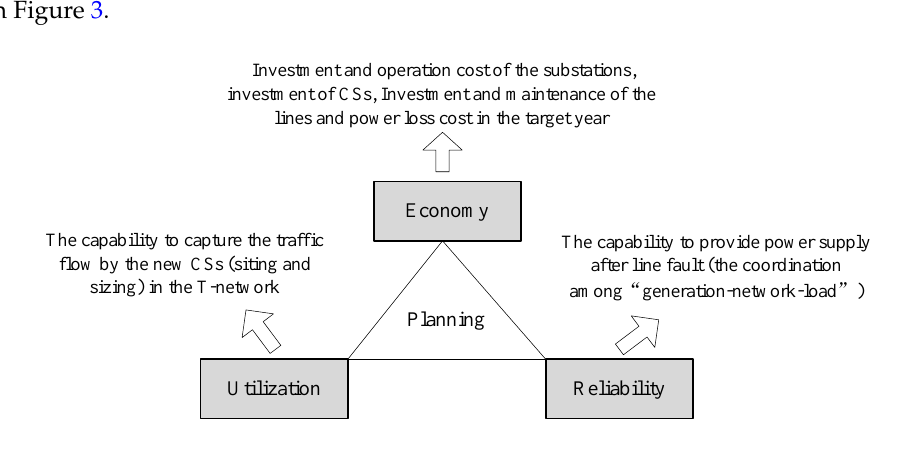
Figure 3. Three objectives for planning.